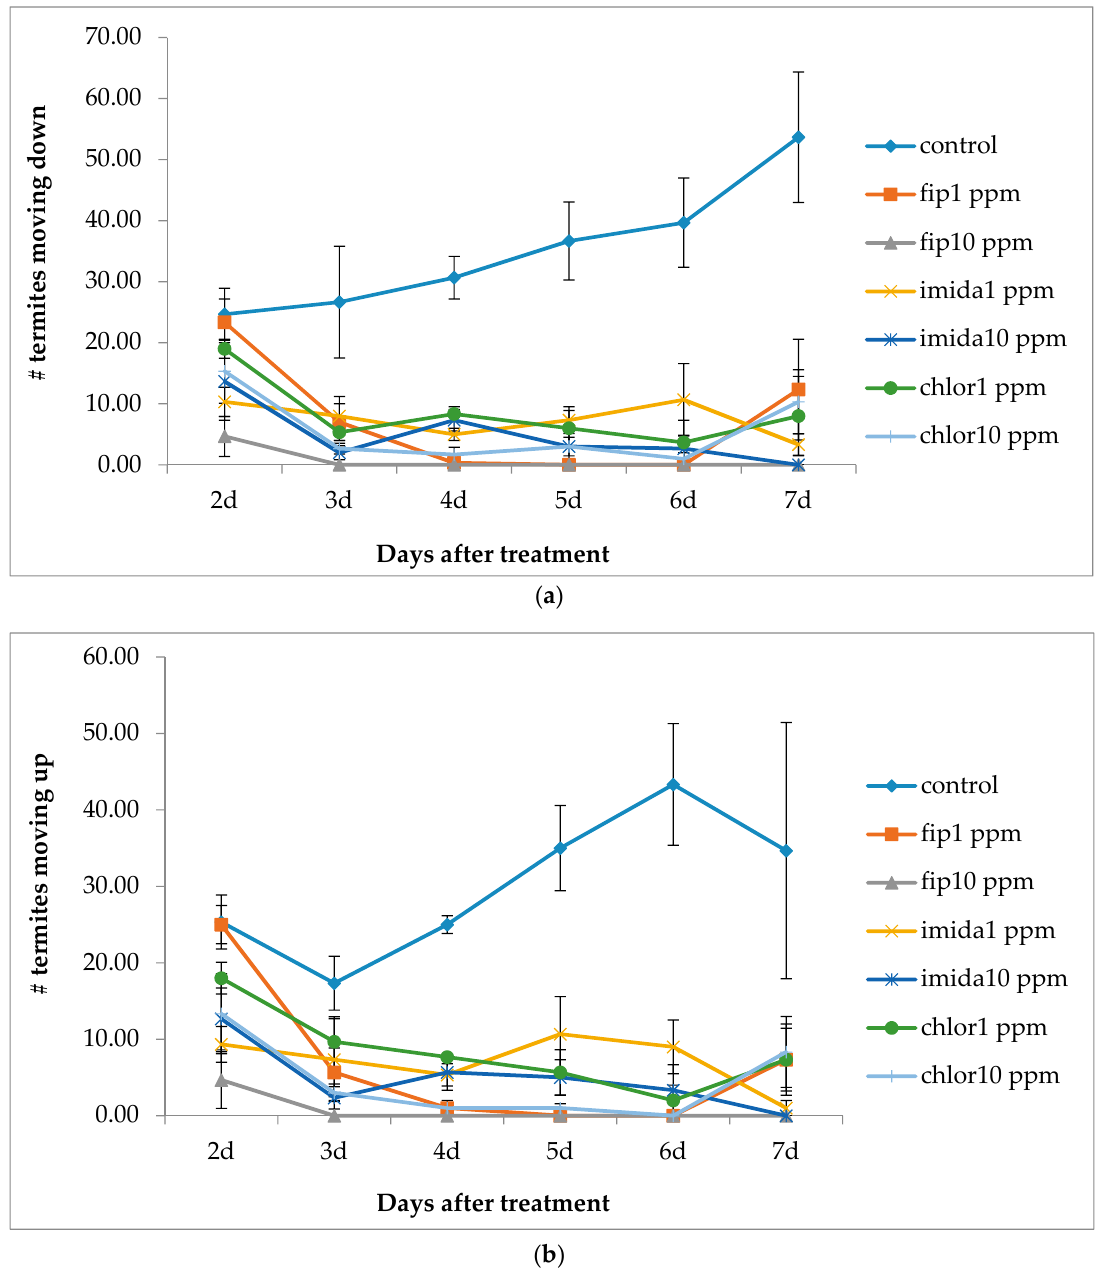
Figure 2. ( a ) Mean number of termites (±SEM) moving downward on the ramp in 5 min observation period from day 2 to day 7 after treatment; ( b ) Mean number of termites (±SEM) moving up on the ramp in 5 min observation period from day 2 to day 7 after treatment.